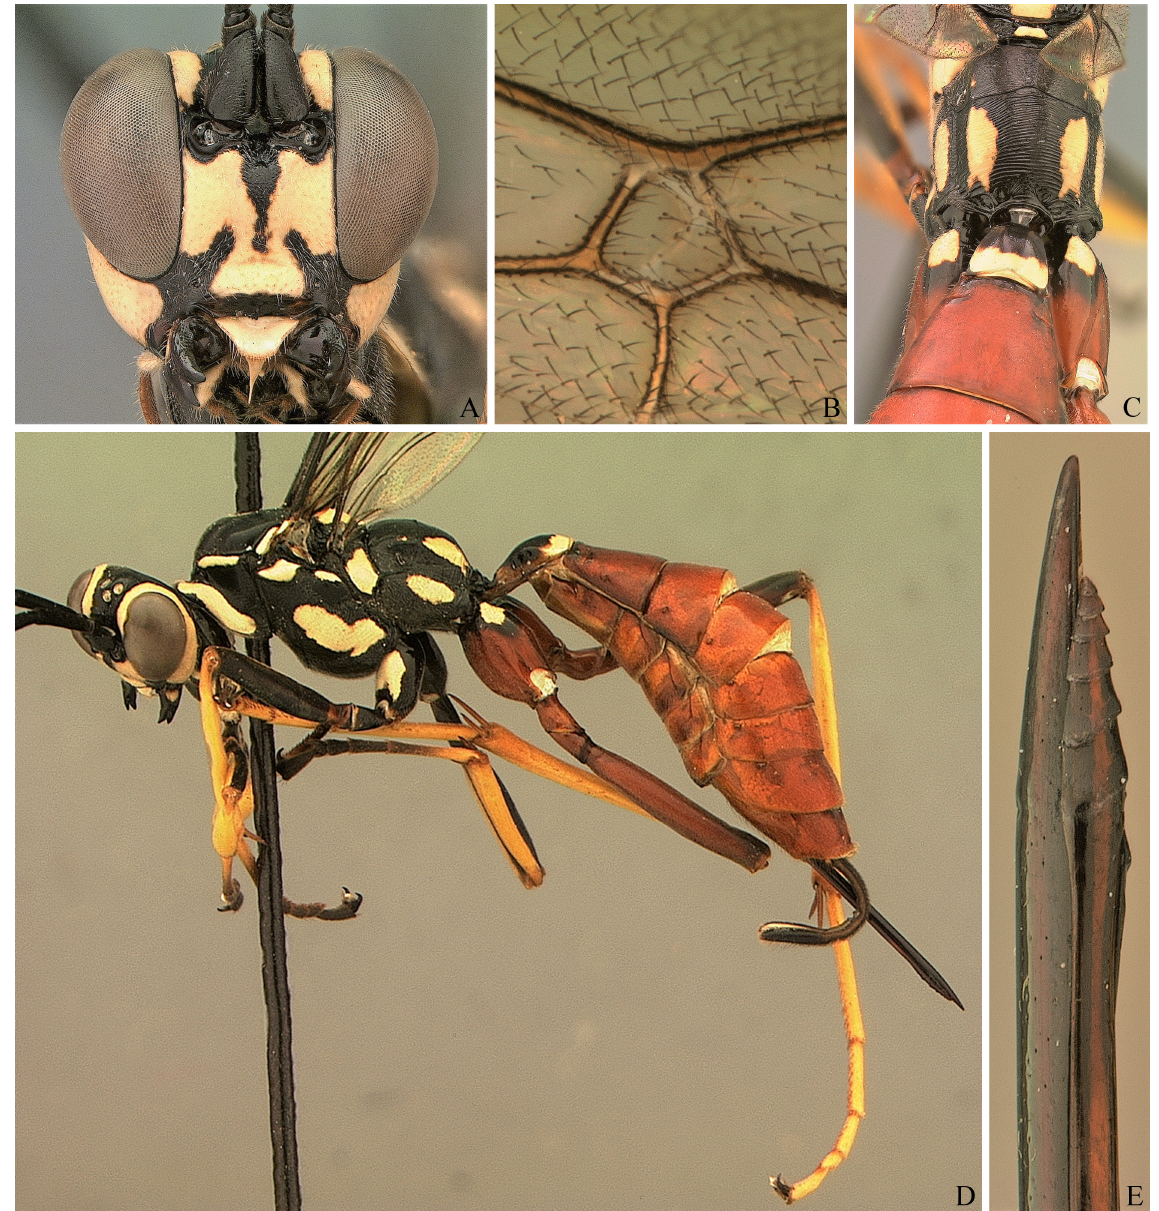
Fig. 7. Distictus ateles sp. nov., holotype (USUC), ♀. A . Head, frontal view. B . Areolet of fore right wing. C . Propodeum + first two tergites, dorsal view. D . Habitus. E . Apex of ovipositor,